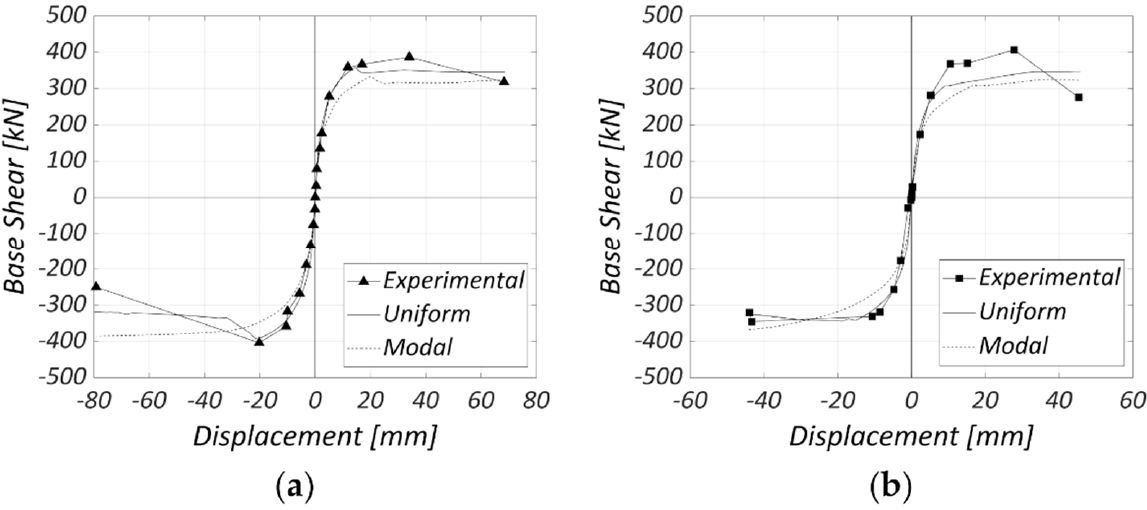
Figure 12. Comparison between backbone and pushover curves: ( a ) Building 2; ( b ) Building 3.